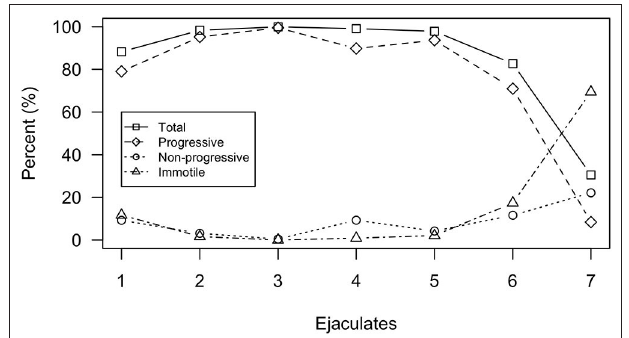
FIGURE 3 | Motility parameters analyzed by the SCA ® system for each individual ejaculate sample. Motility parameters include total motility, progressive motility, non-progressive motility, and